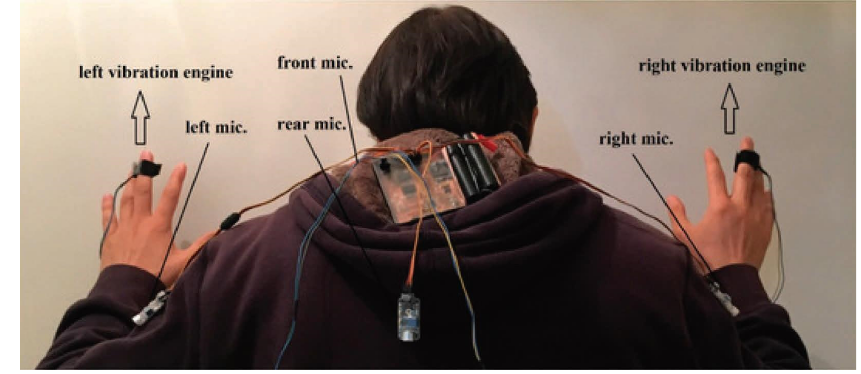
Figure 5: Testing a wearable device on the user in real time